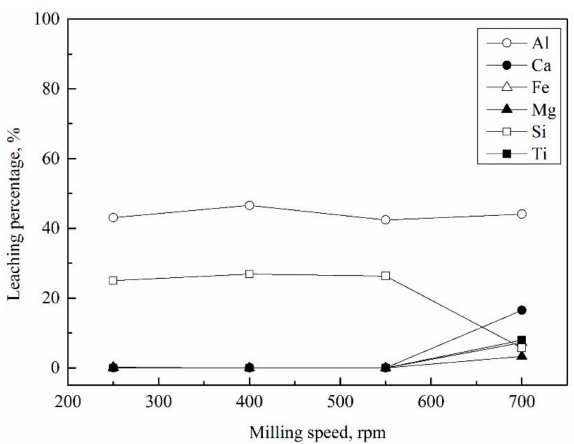
Figure 4. The effect of milling speed on the leaching of the oxides from the mechanically activated